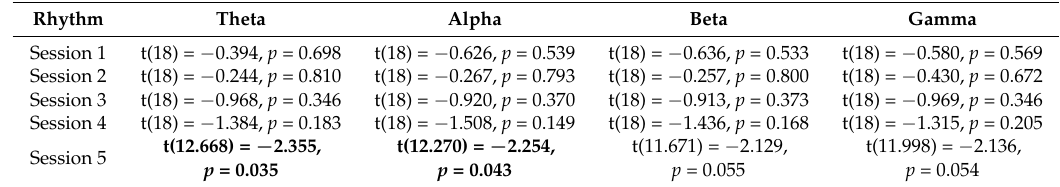
Figure 5. Changes in other rhythms throughout neurofeedback training in the NF and Sham-NF groups. ( a ) Relative power of Alpha1 (8–10 Hz) and Alpha2 (10–12 Hz) rhythms during training sessions in both groups. * represents ( p < 0.05) across groups; ( b ) Relative power of different rhythms from theta to gamma in the 5th session. * represents ( p < 0.05) across groups. Table 2. Across group analysis of relative power in different